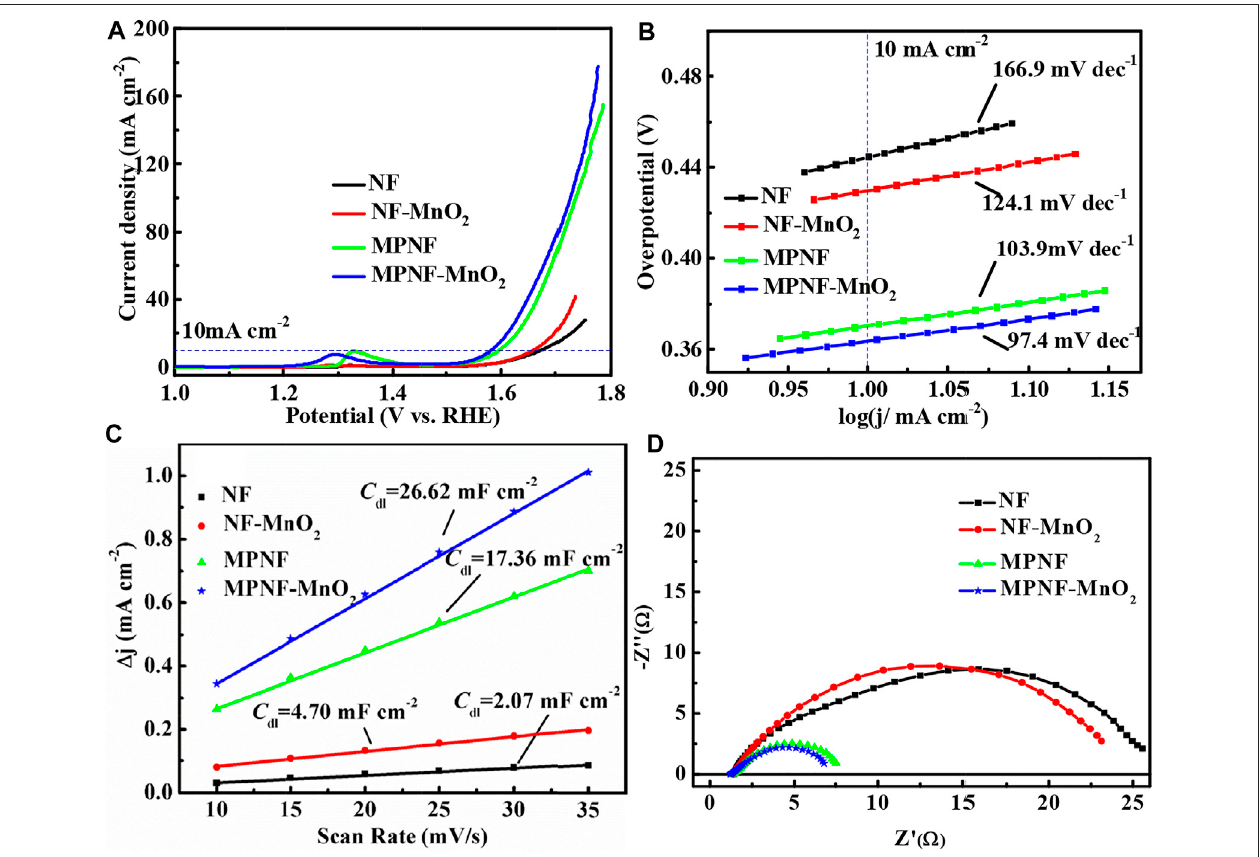
FIGURE4| OERcurvesofNF,MPNF,NF-MnO 2 ,andMPNF-MnO 2 . (A) LSVat5 mV/sofscanningrate, (B) Tafelslopelinear, (C) C dl linear fi tbyC-Vcurve,and (D) EIS curves at 1.62 V (VS RHE).